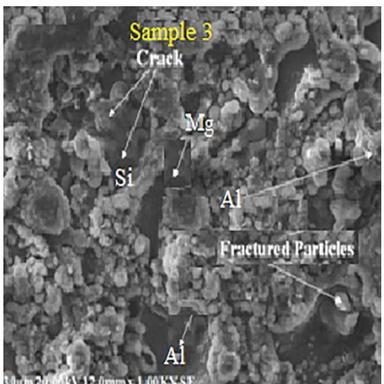
CAST MMNC Sample S3 at 30 mm Scale range.